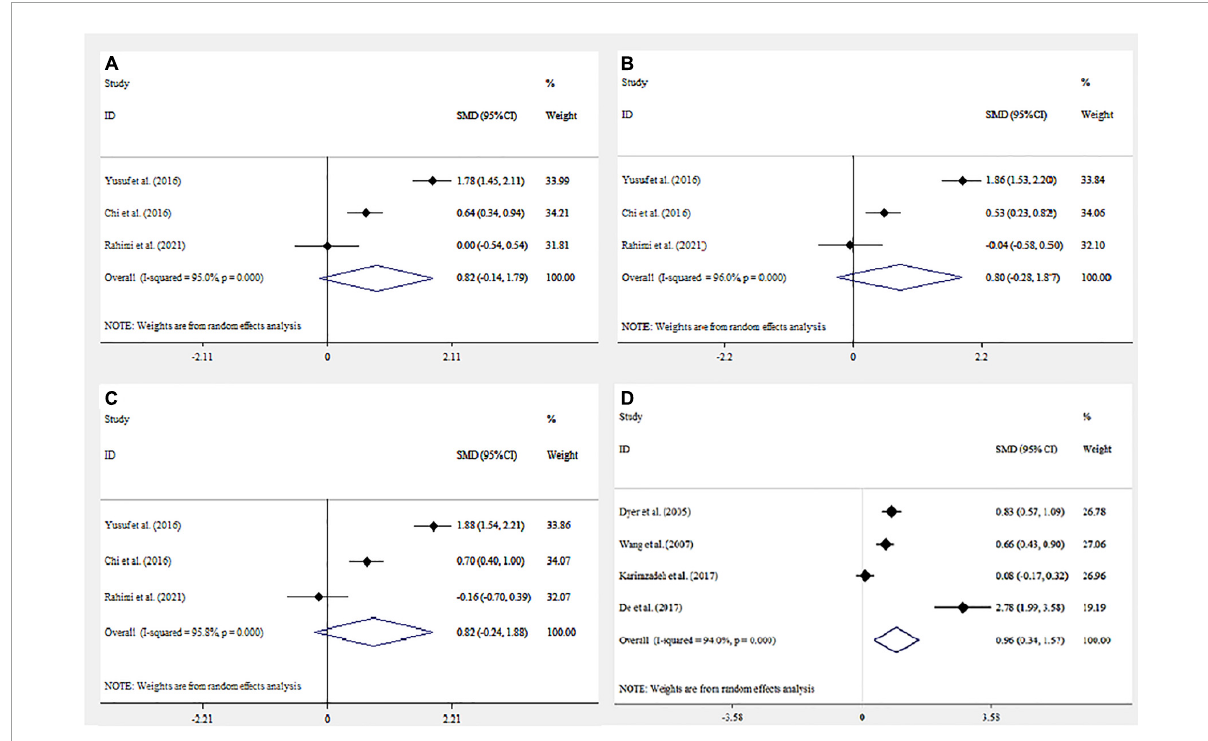
FIGURE3 Forest plot mean difference and 95% confidence intervals (CI) of the meta-analysis on psychological assessment score and association with infertility: Depression Anxiety Stress Scale (DASS) (A–C) (Anxiety, Depression, and Stress respectively); Symptom Checklist 90 (SCL90) (D) . Horizontal lines represent 95%